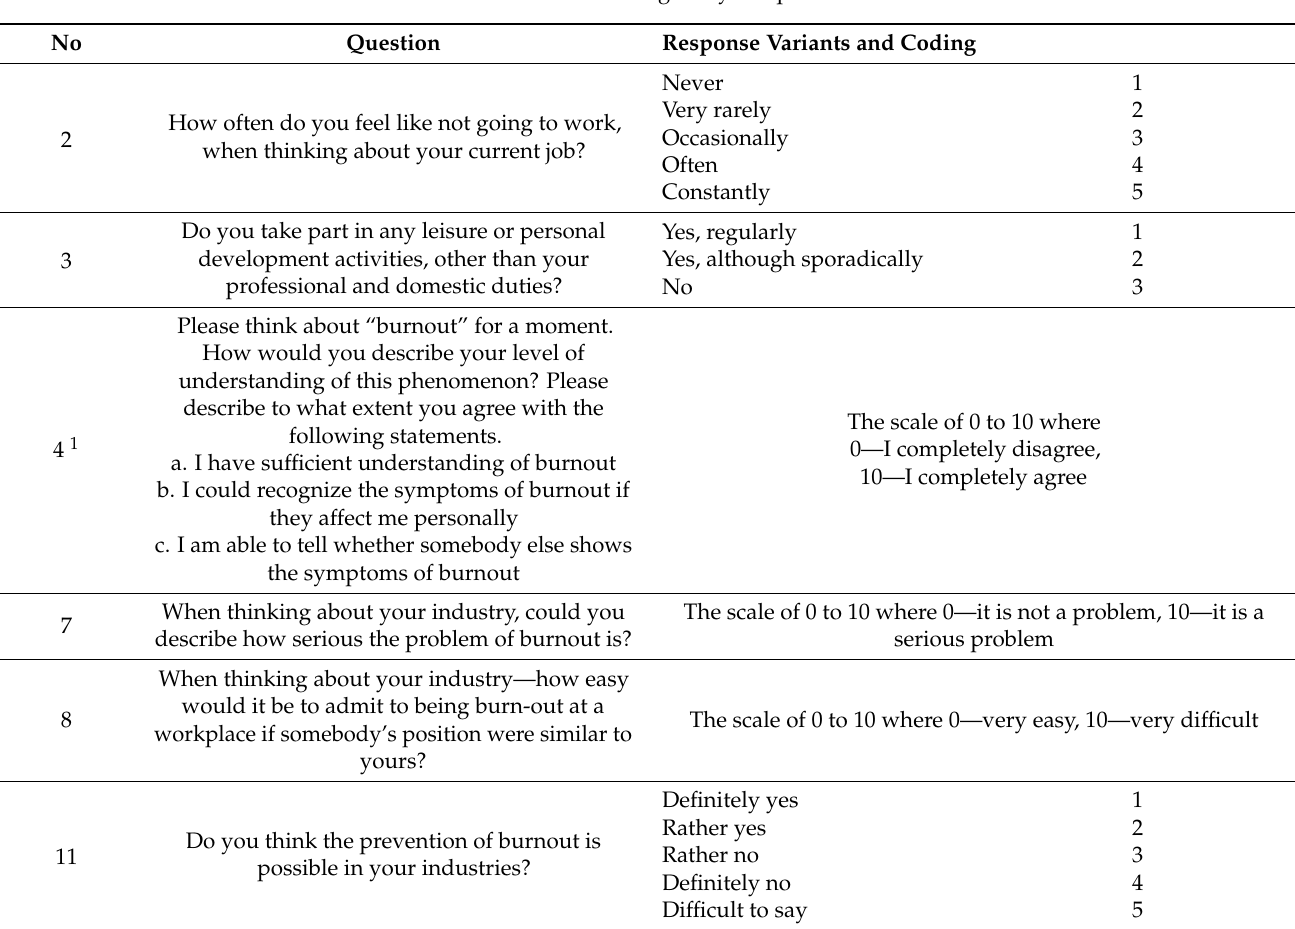
Table A2. The remaining analysed